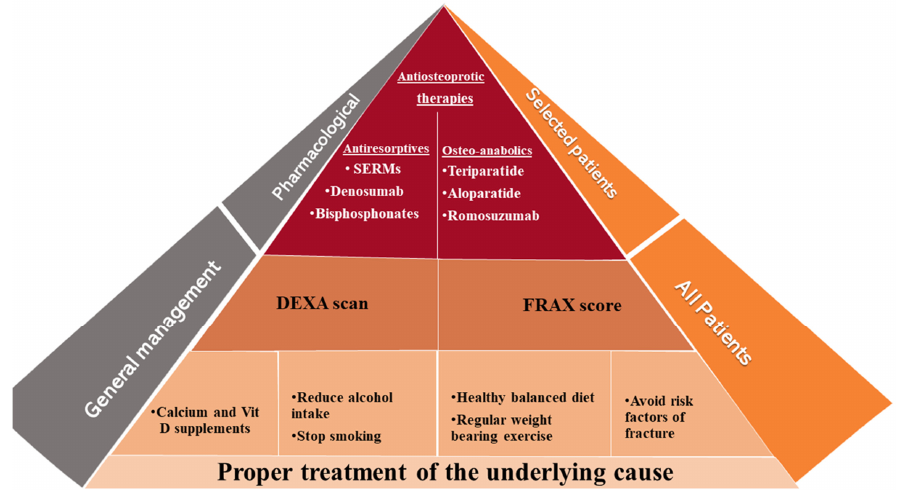
Figure 3. Approach for prevention and management of secondary osteoporosis. Correction of the underlying causes of secondary osteoporosis is the cornerstone of prevention and treatment. All patients can benefit from non-pharmacological intervention, DEXA scan and assessment of fracture risk. Anti-osteoporotic medications (antiresorptives and osteoanabolics) can be used in selected cases with high fracture risk. DEXA: dual-energy X-ray absorptiometry, FRAX: fracture-risk algo- rithm, SERM: Selective estrogen receptor modulators.